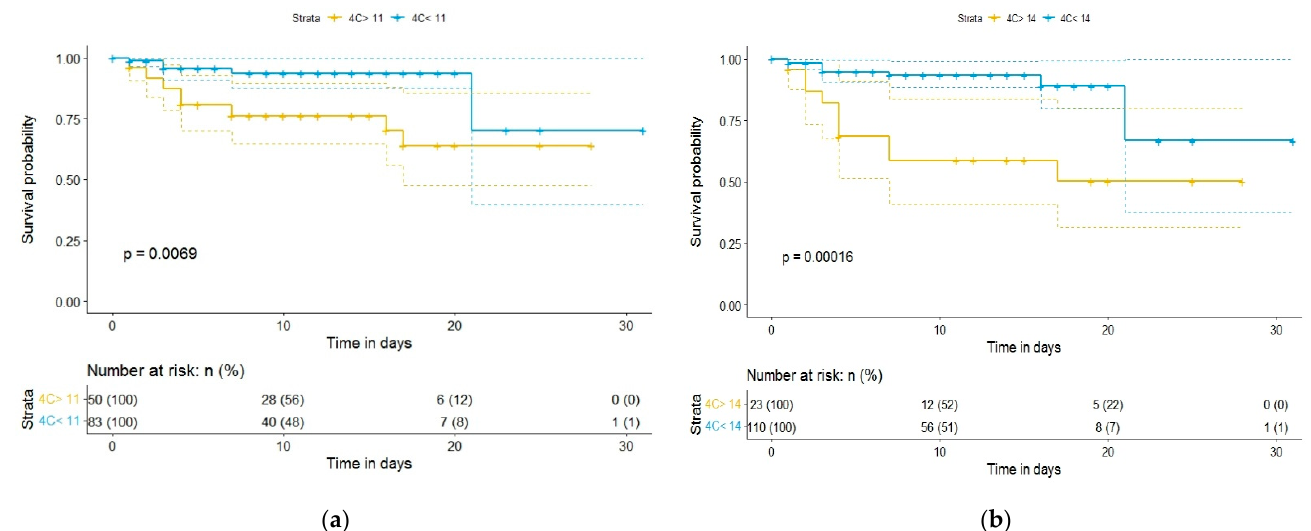
Figure 2. Kaplan–Meier survival curves of hospitalized COVID-19 patients: ( a ) according to 4C